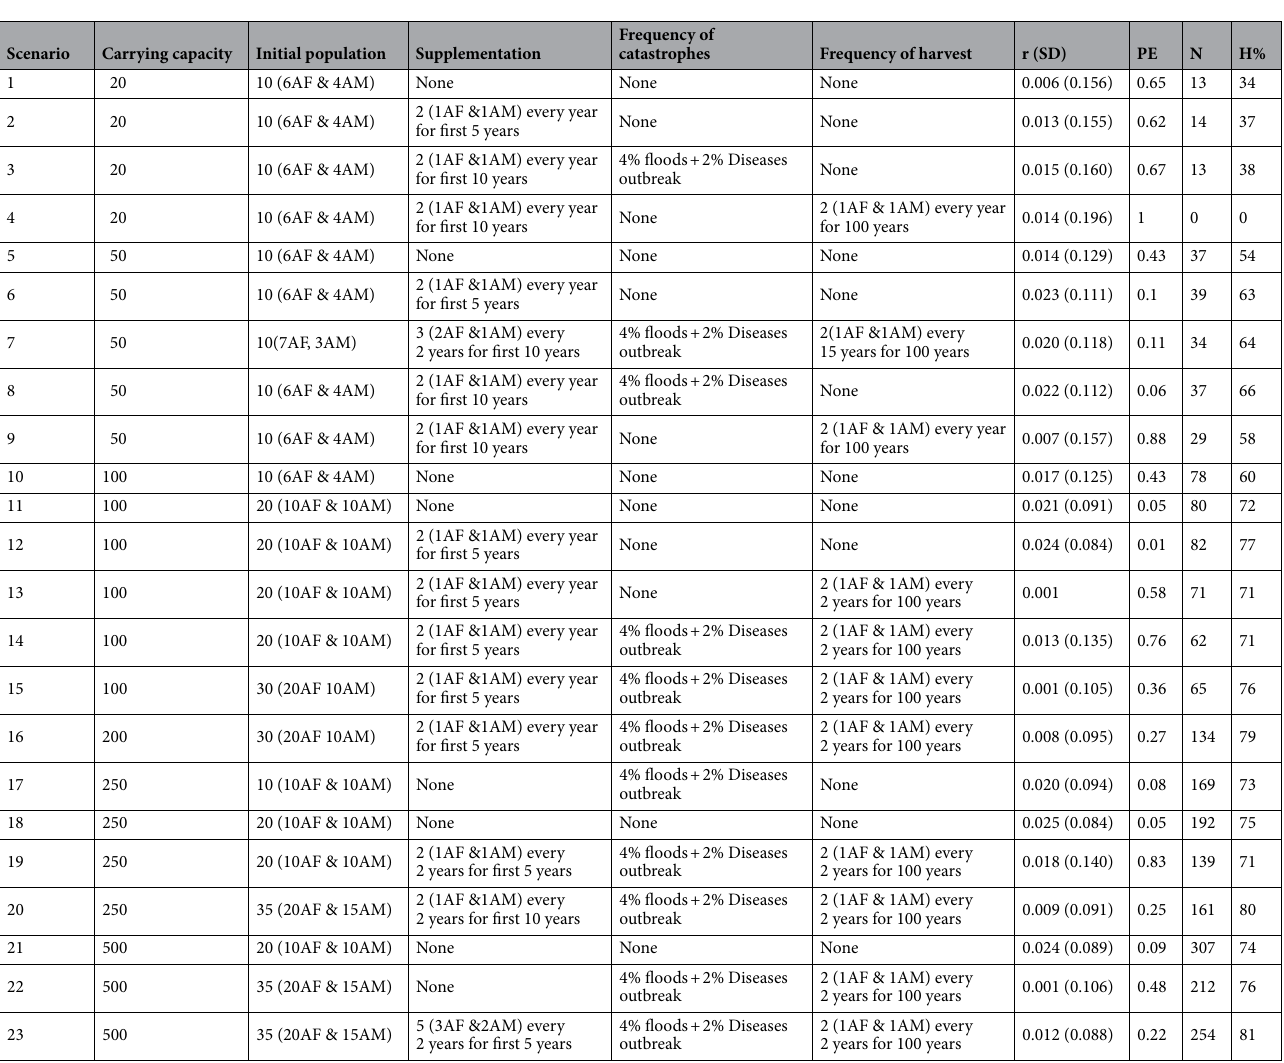
Table 3. Results of 500 runs of population habitat viability analysis of wild swamp buffalo populations with different scenarios of carrying capacity, poaching, catastrophe, initial population size and supplementation over a period of 100 years. Here AF – adult female, AM- adult male, r = growth rate of population, (SD) = standard deviation, N = population size at the end of 100 years, PE = probability of Extinction and H = heterozygosity of the population at the end of 100